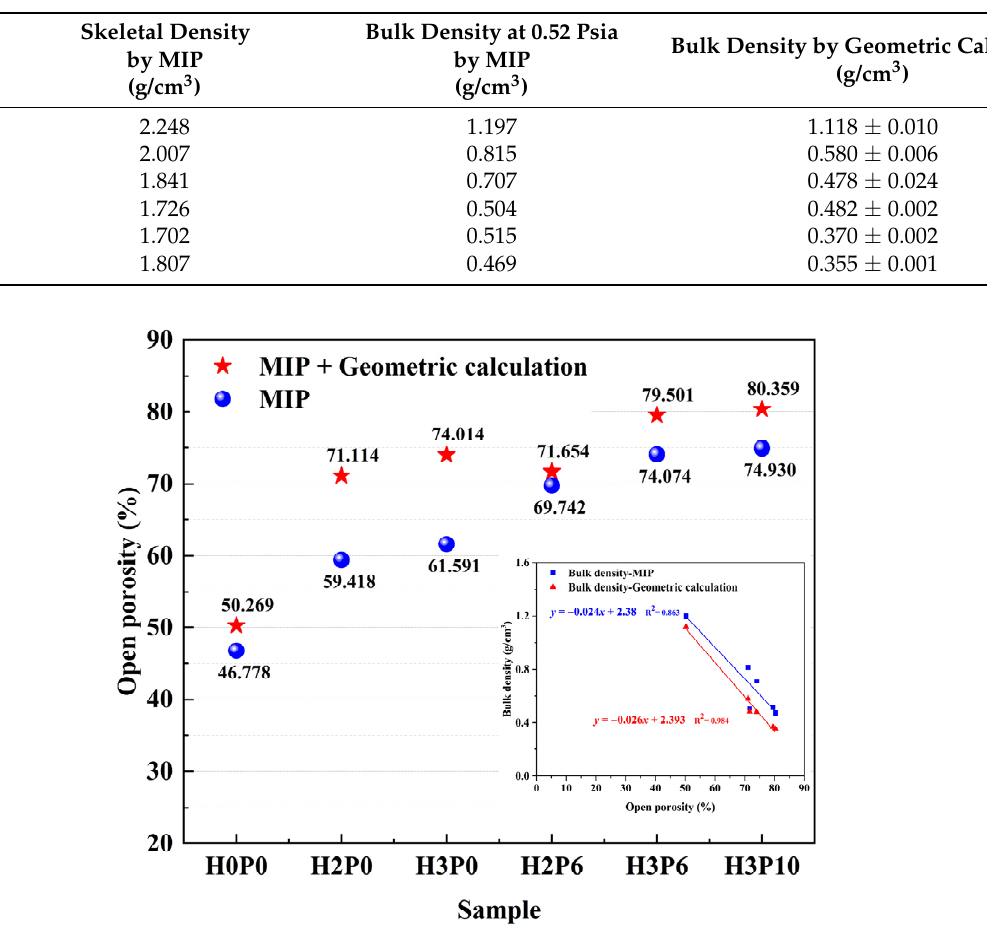
Table 4. Skeletal and bulk densities of geopolymer foams.